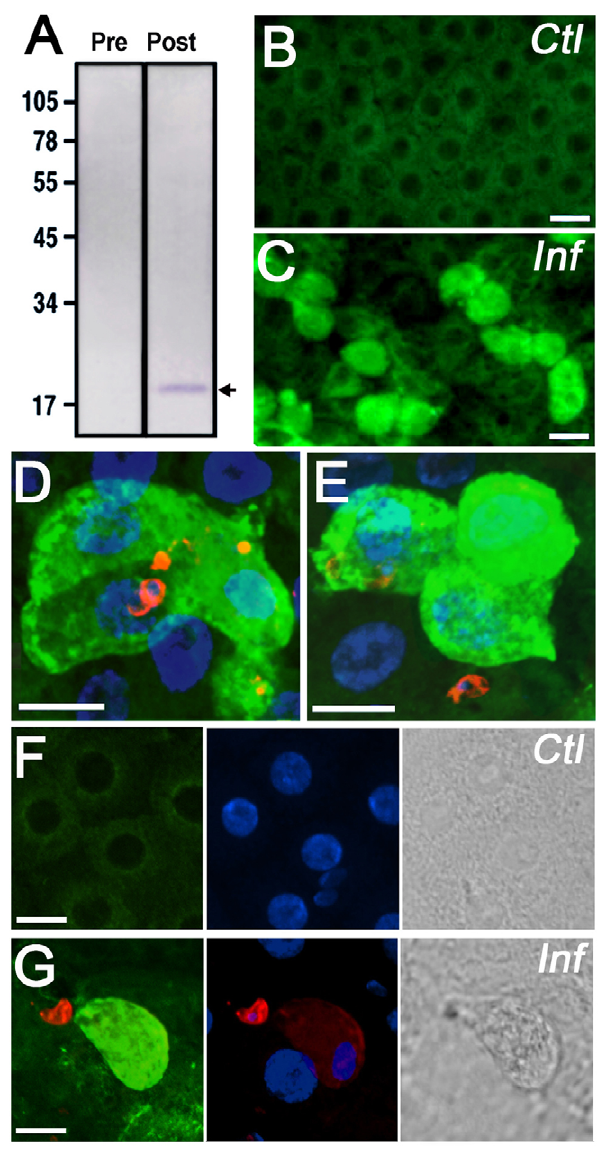
Figure 4. AgApoLp-III protein detection and subcellular localization in control and Plasmodium -infected midguts. (A) Western blot analysis of hemolymph from adult females probed with pre-immune or polyclonal anti-AgApoLp-III antiserum. A single band of expected molecular weight (19 kDa) for the mature protein was detected and is indicated by the arrow. (B–G) Subcellular localization of AgApoLp-III (green) in control (B and F) and infected (C, D, E, and G) midguts. The ookinete surface was stained using anti-Pb28 monoclonal antibodies (red) and nuclei with DAPI (blue). Phase contrast images of the midgut surface in control (F) and infected (G) midguts are shown in the right panels.